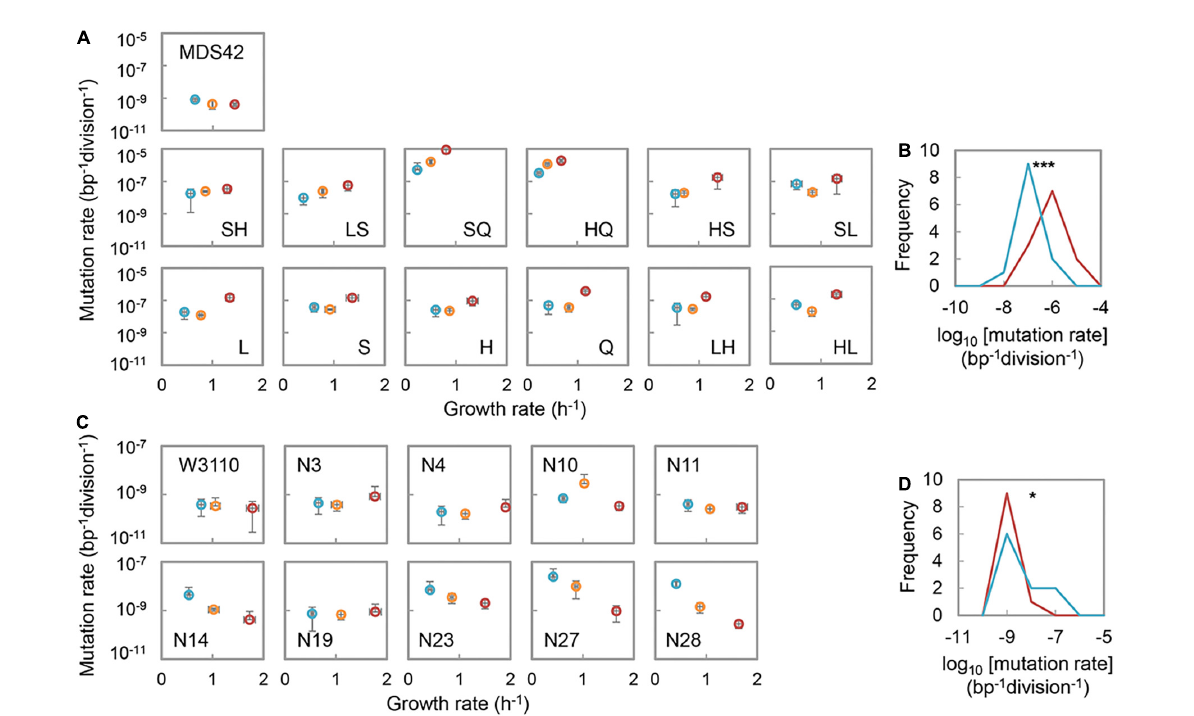
FIGURE1 Nutritional richness-dependent mutation and growth rates. (A) Mutation and growth rates of the MDS collection in various media. The abbreviations of the strains, i.e., the genes deleted, are indicated. S, H, L, and Q represent the deleted genes of mutS , mutH , mutL , and dnaQ , respectively. Double letters indicate the double deletion of the genes. Blue, orange, and red circles represent the media of M63, MAA, and LB, respectively. Standard errors of both mutation and growth rates are indicated ( N = 3 ∼ 6). (B) Distributions of the mutation rates of the MDS collection. Red and blue indicate the media of LB and M63, respectively. Frequency represents the number of strains. Statistical significance is indicated (*** p < 0.001). (C) Mutation and growth rates of the KHK collection in various media. The abbreviations of the strains are indicated. Blue, orange, and red circles represent the media of M63, MAA, and LB, respectively. Standard errors of both mutation and growth rates are indicated ( N = 3 ∼ 6). (D) Distributions of the mutation rates of the KHK collection. Red and blue indicate the media of LB and M63, respectively. Frequency represents the number of strains. Statistical significance is indicated (* p <